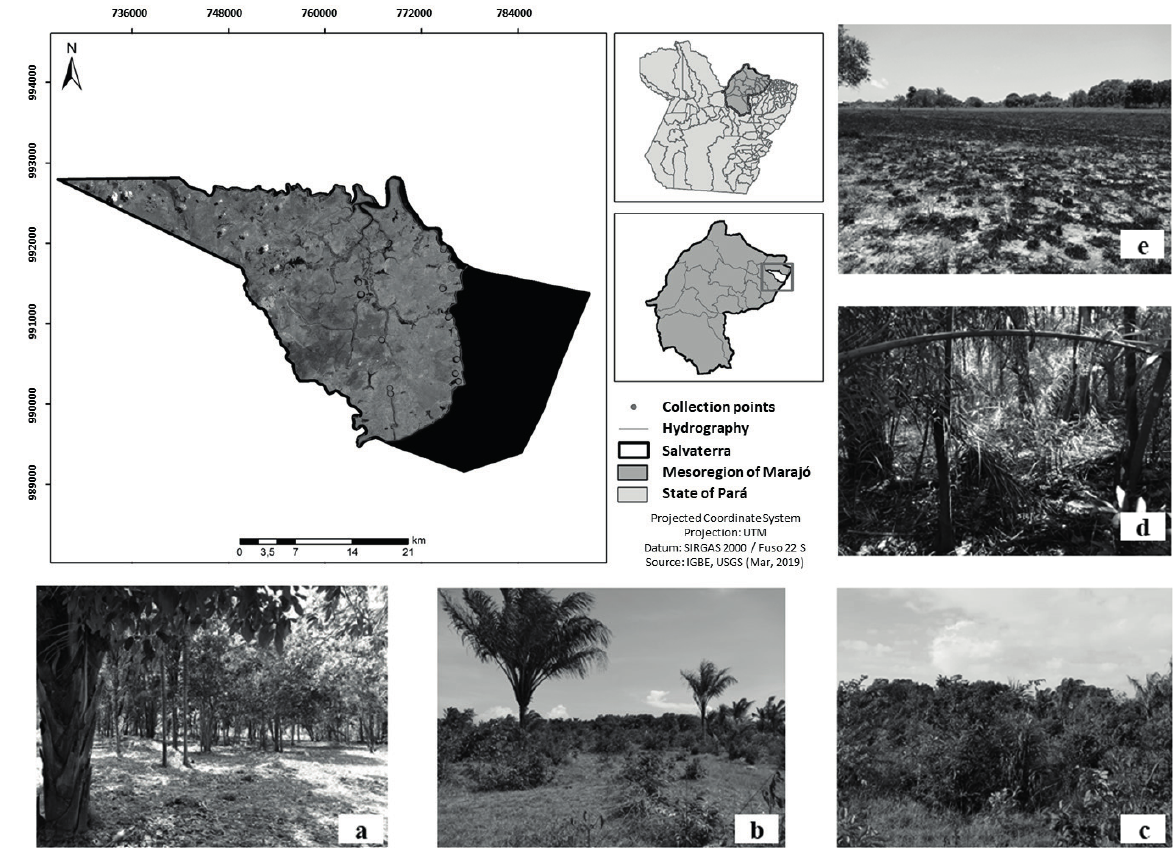
Figure 1. Location of the communities in which tucumã-do-pará individuals were mapped in Salvaterra, Pará, Brazil, and physiognomies of occurrence: a) Backyard; b) Savannah Park; c) Transition between Savannah grassland and Savannah Park; d) Secondary Forest; e) Savannah